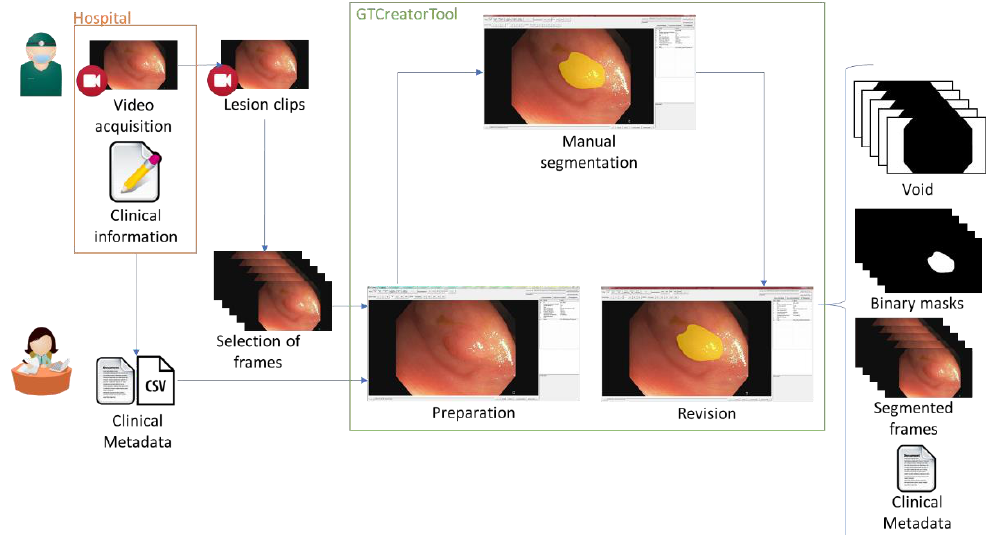
Figure 1. Annotation protocol for the PICCOLO dataset generation.